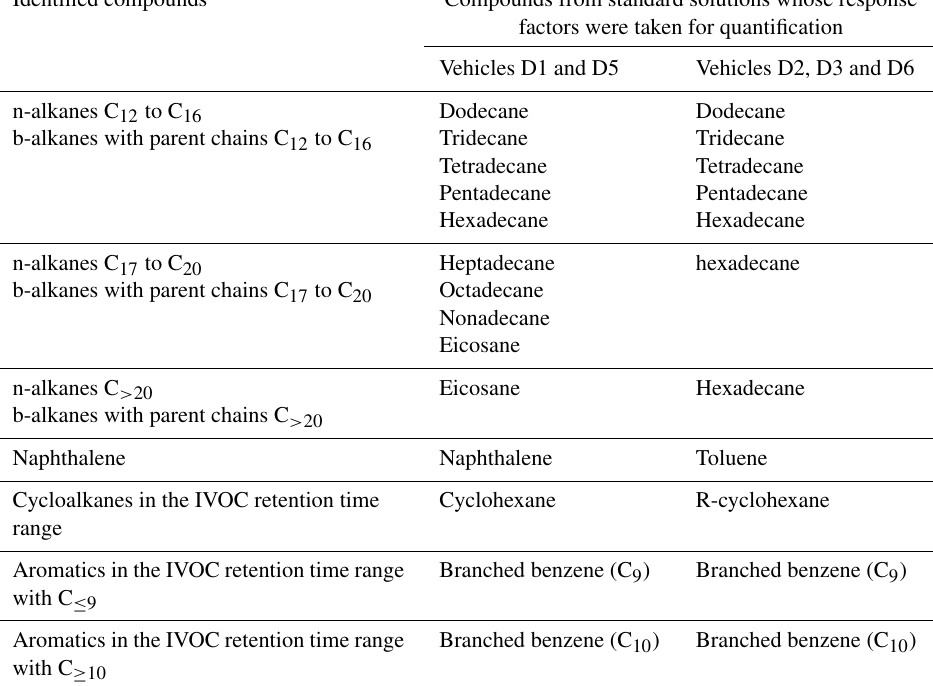
Table 2. List of the compounds from the standard solutions whose response factors were chosen for quantification of the identified compounds for vehicles D1, D4 and D5 as well as vehicles D2, D3 and D6. The identified alkanes are sorted by the number of carbon atoms in their parent chain: C 12 to C 16 , C 17 to C 20 and C > 20